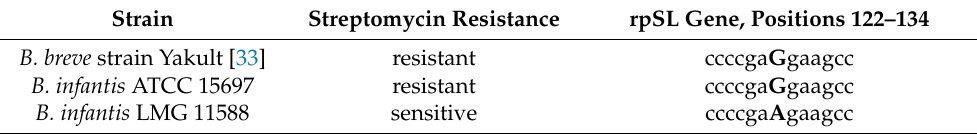
Table 5. rpSL gene sequence at position 128 (of B. breve rpSL